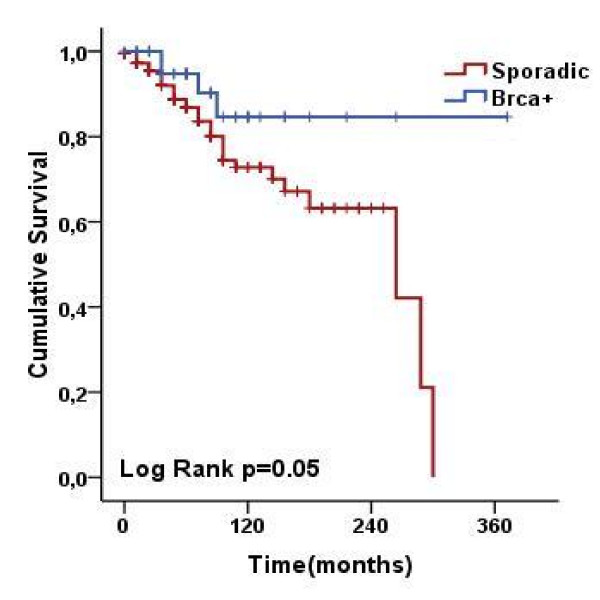
Probability of survival in 80 BRCA1 breast cancer cases and 320 sporadic breast cancer controls matched for age and tumour grade and stage, using Kaplan-Meier analysis. There was a statistically significant difference between the two groups (log-rank test, p = .05).